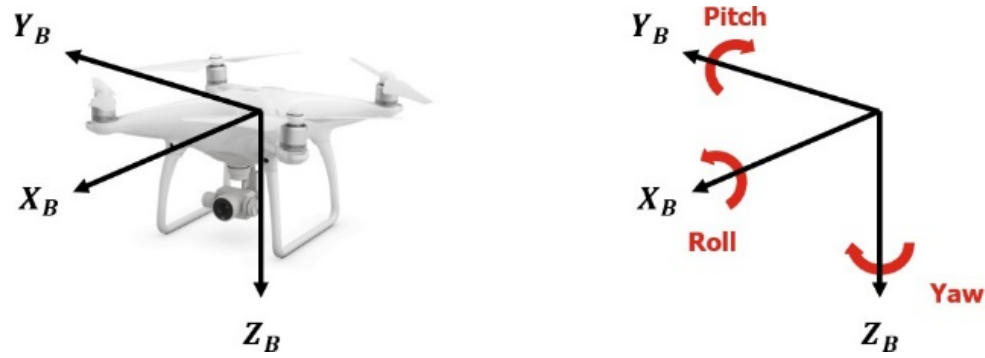
Figure 2. Multi-copter reference coordinate system and coordinate system reference direction.